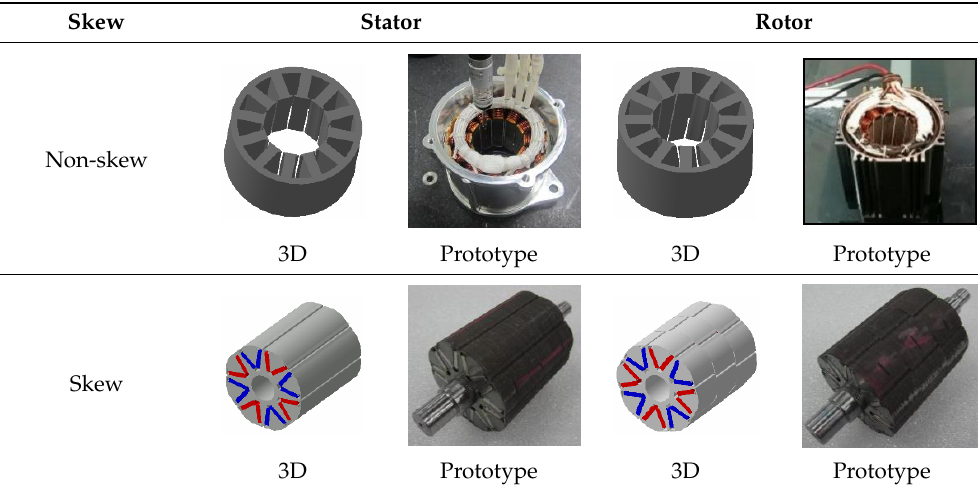
Table 2. 3D and prototypes with the different skew designs.